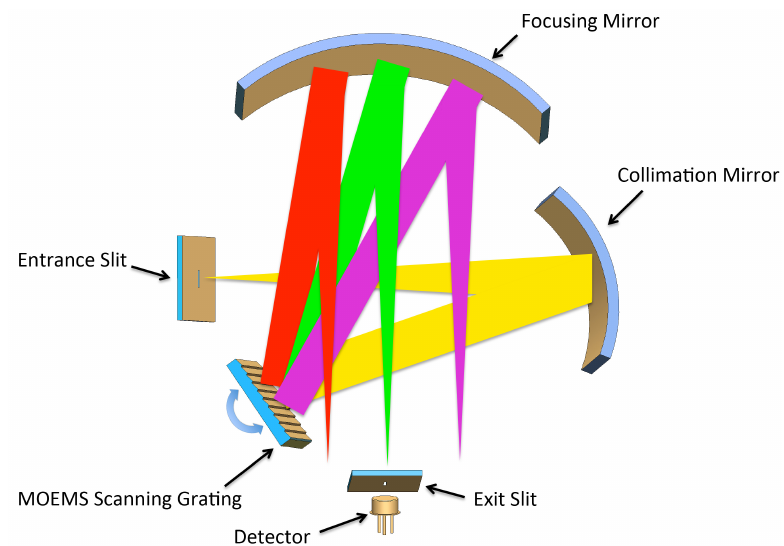
Figure 2. Principal drawing of the spectrometer showing the asymmetrical crossed Czerny–Turner setup.